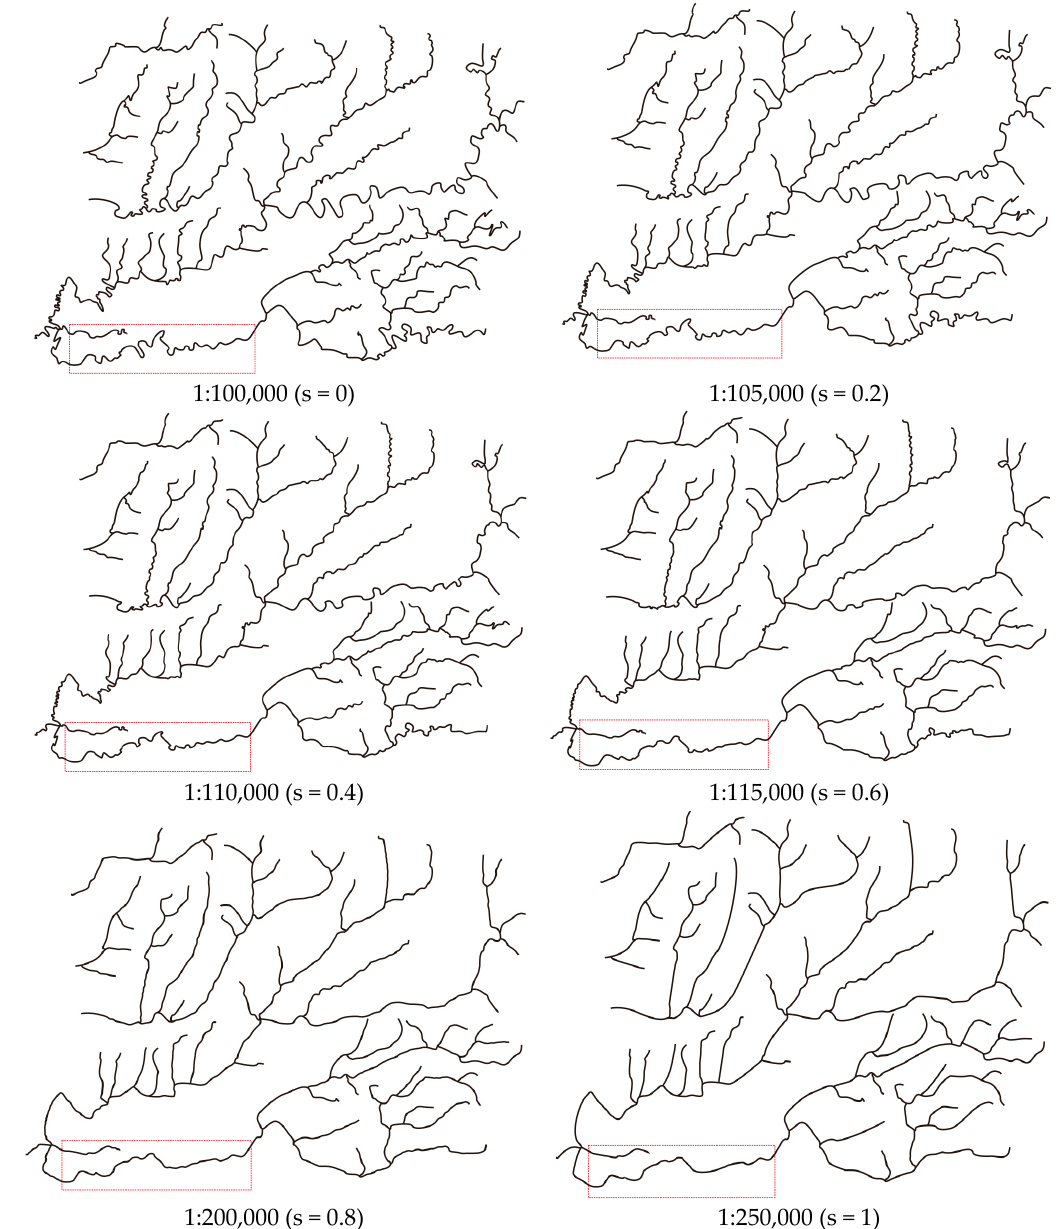
Figure 9. River network morphing generated by the SABM method.